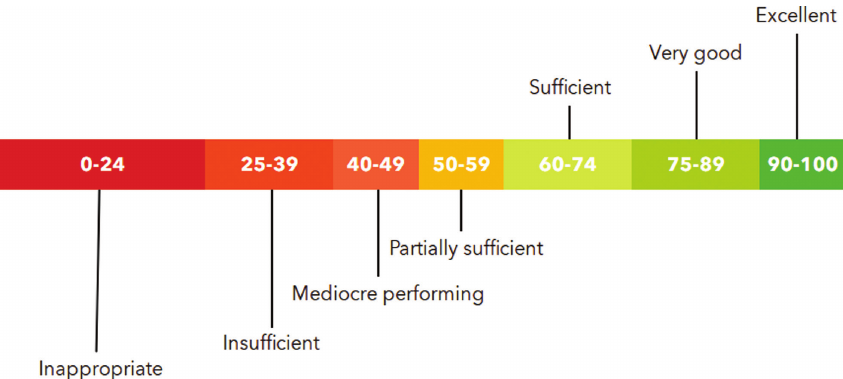
Fig. 1: The Public Sector Questionnaire